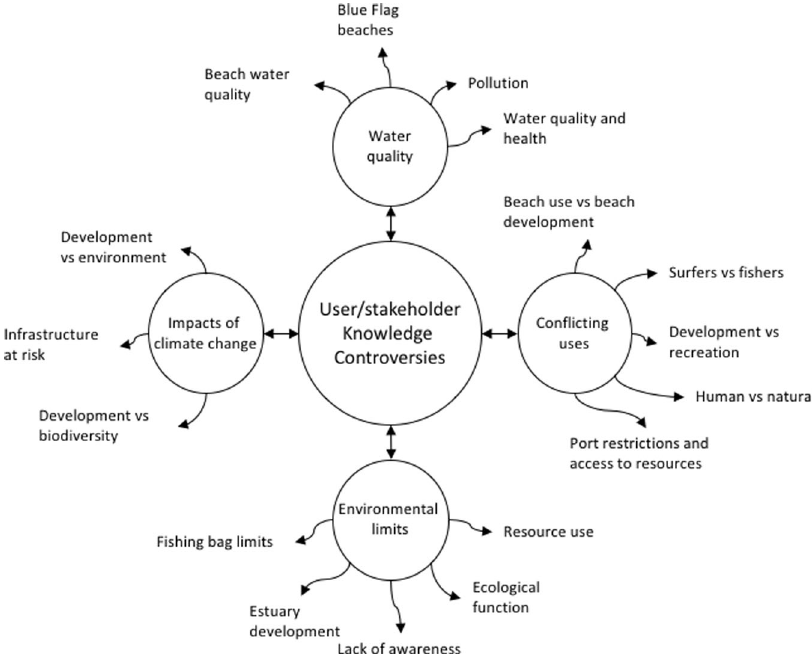
Fig. 1 Social-environmental knowledge controversies of the Golden Mile, Durban, South Africa as identi fi ed by the Competency Group (Competency Workshop No. 3, 30 May